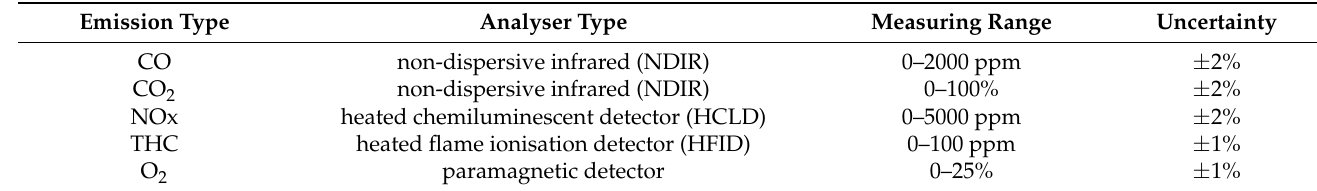
Table 2. The emission analyser type and measuring